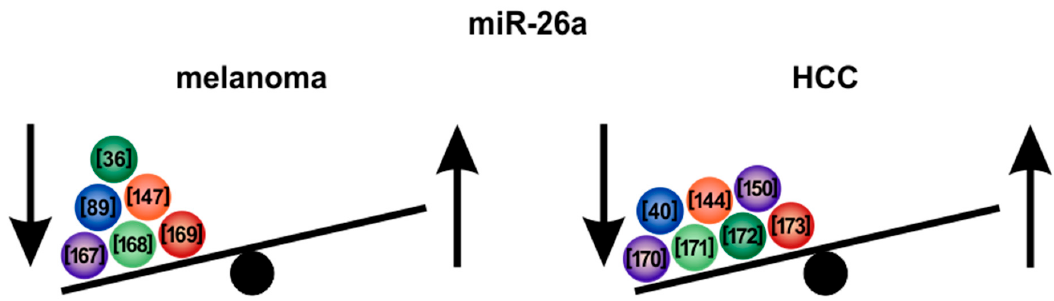
Figure 5. Downregulation of tumor-suppressor miR-26a in melanoma and HCC. Several studies (numbers in brackets indicate according references) showed di ff erential expression of miR-26a in melanoma and HCC.